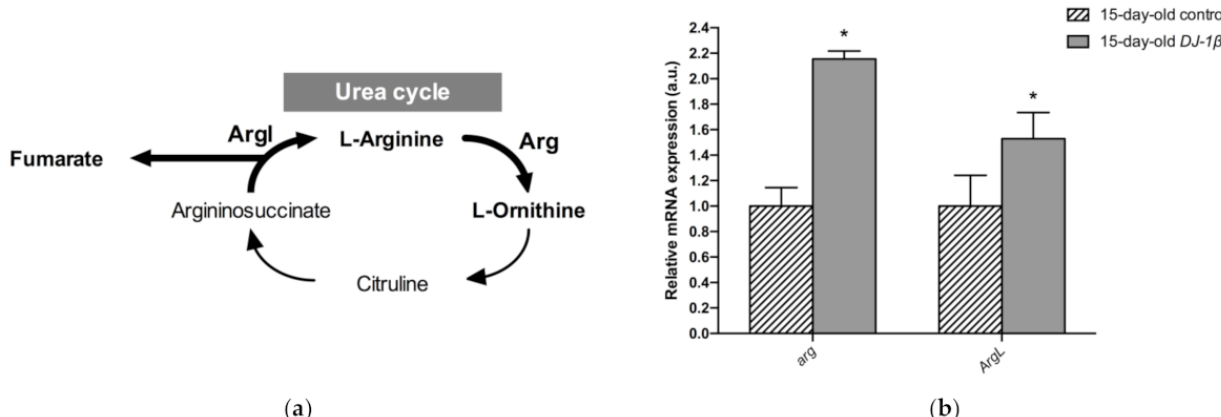
Figure 5. Metabolic switch to glycolysis in 15-day-old DJ-1 β mutant flies. ( a ) Relative ATP levels in 15-day-old DJ-1 β mutant flies compared to controls of the same age. ( b ) Relative enzymatic activity of aconitase (Aco) and succinate dehydrogenase (SDH) from the TCA cycle in 15-day-old DJ-1 β mutant flies compared to controls. In all cases, error bars show s.d. from three independent experiments, in which three biological replicates were used (*, p < 0.05).